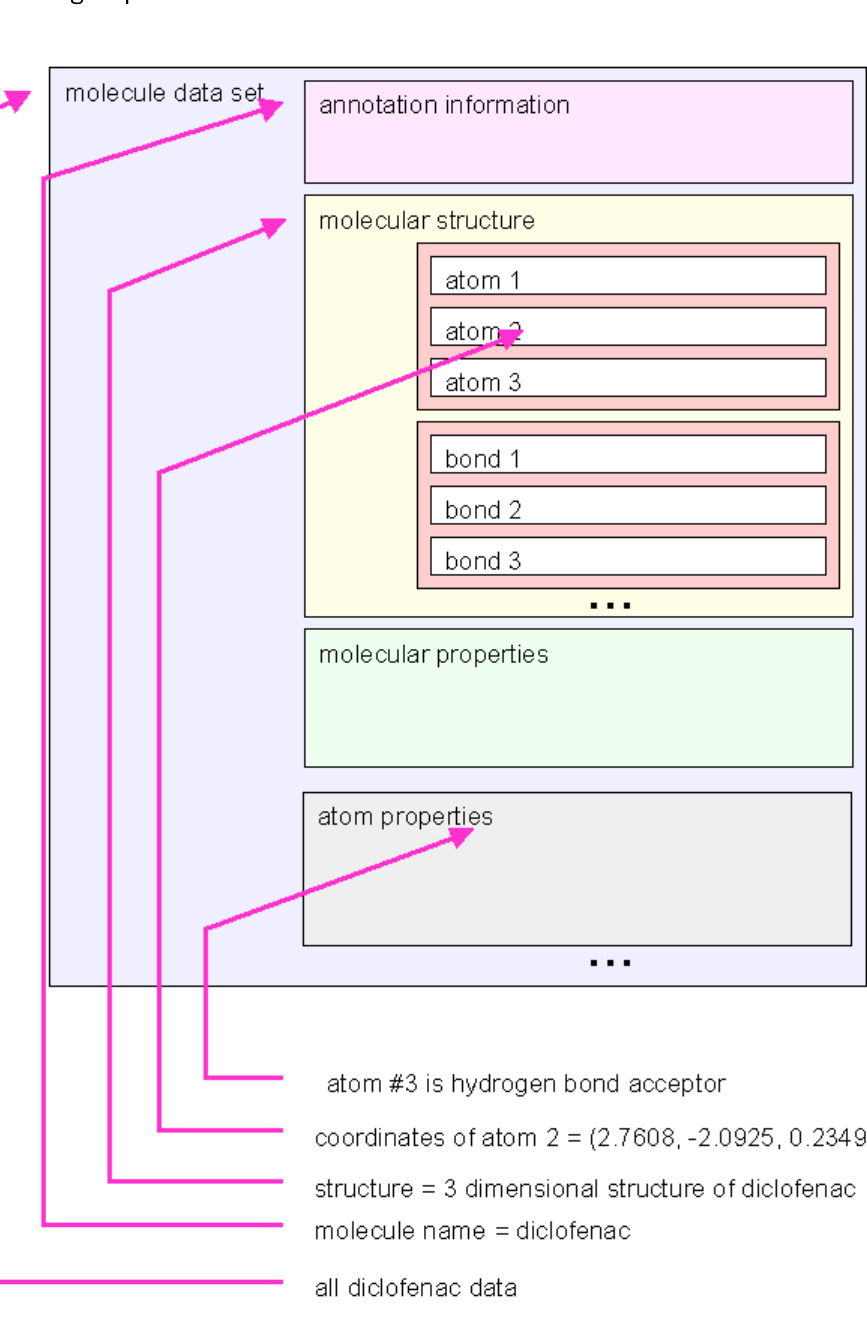
Figure 4: Schematic representation of a marvin dataset. The molecule data can be handled on different levels of graining. The marvin library function provide access to many types of grouped